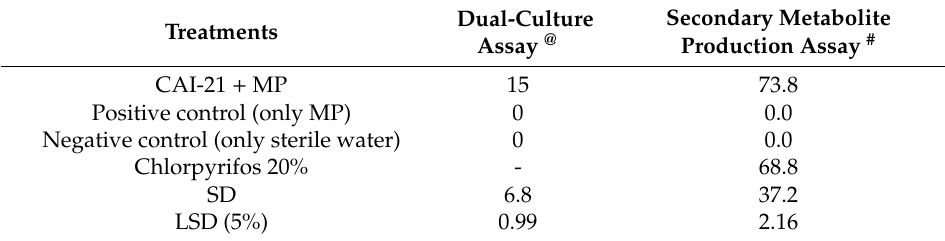
Table 1. In vitro inhibitory activity of S. albus CAI-21 against M. phaseolina —dual-culture assay and secondary metabolite production assay .